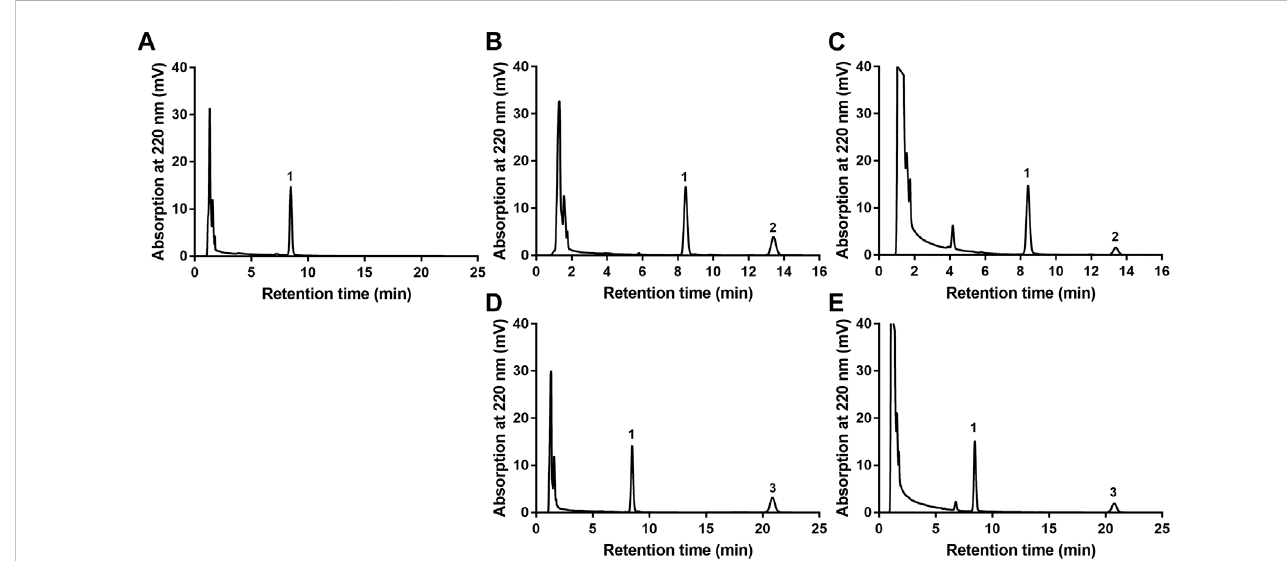
FIGURE 2 HPLCchromatogramsofEAorEBinHLMs. (A) blankHLMs; (B) blankHLMsspikedwithEA; (C) incubationofEAwithHLMs; (D) blankHLMsspikedwithEB; (E) incubation of EB with HLMs; 1: IS, 2: EA, 3: